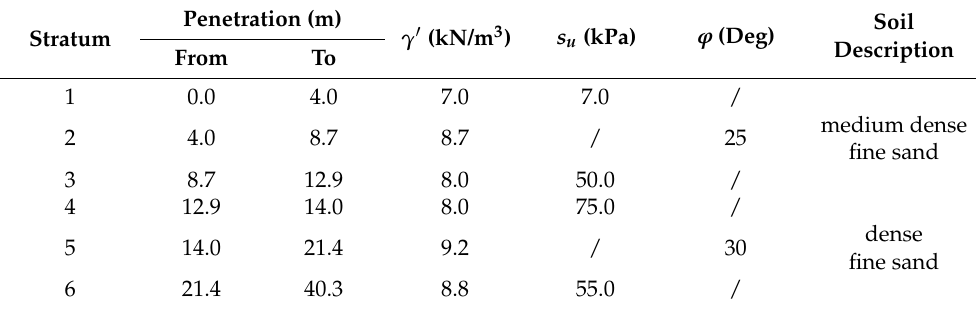
Table 3. Properties of seabed soils at the Location−1.